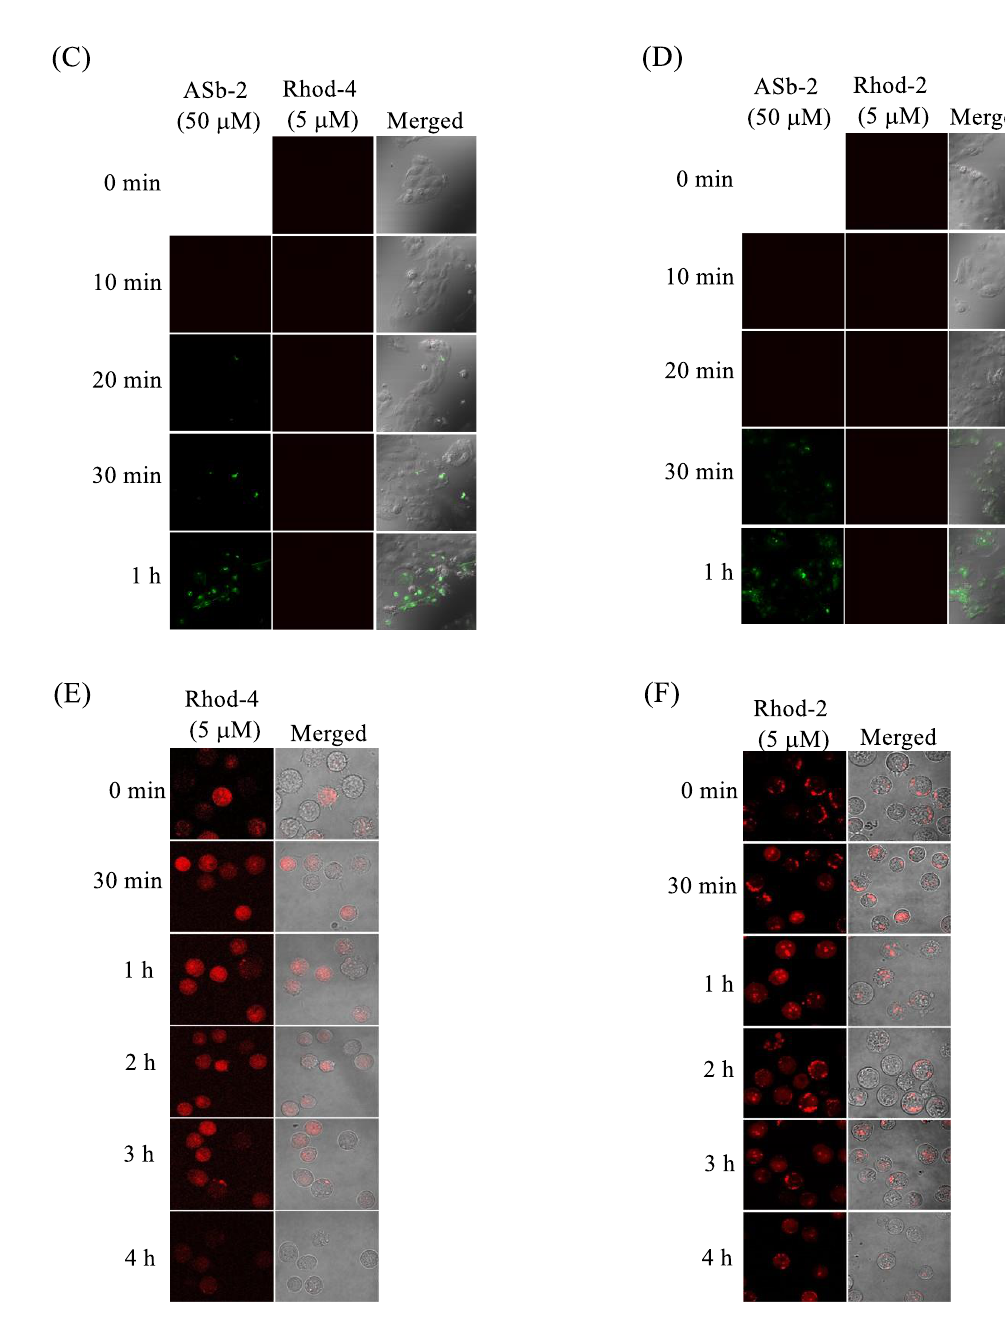
Figure 7. ( A ) Typical luminescence confocal microscopic images (Fluoview, FV-1000, Olympus) of Jurkat cells treated with ASb-2 (50 µM) and then stained with Rhod-4/AM (5 µM) at 37 °C. ( B ) Typical confocal microscopic images of Jurkat cells treated with ASb-2 (50 µM) and then stained with Rhod-2/AM (5 µM) at 37 °C. ( C ) Typical luminescence confocal microscopic images (Fluoview, FV-1000, Olympus) of IMR-90 cells treated with ASb-2 (50 µM) and then stained with Rhod-4/AM (5 µM) at 37 °C. ( D ) Typical confocal microscopic images of IMR-90 cells treated with ASb-2 (50 µM) and then stained with Rhod-2/AM (5 µM) at 37 °C. ( E ) Typical luminescence confocal microscopic images of Jurkat cells treated with celastrol (30 µM) and then stained with Rhod-4/AM (5 µM) at 37 °C. ( F ) Typical confocal microscopic images of Jurkat cells treated with celastrol (30 µM) and then stained with Rhod-2/AM (5 µM) at 37 °C. Scale bar: 25 µm.